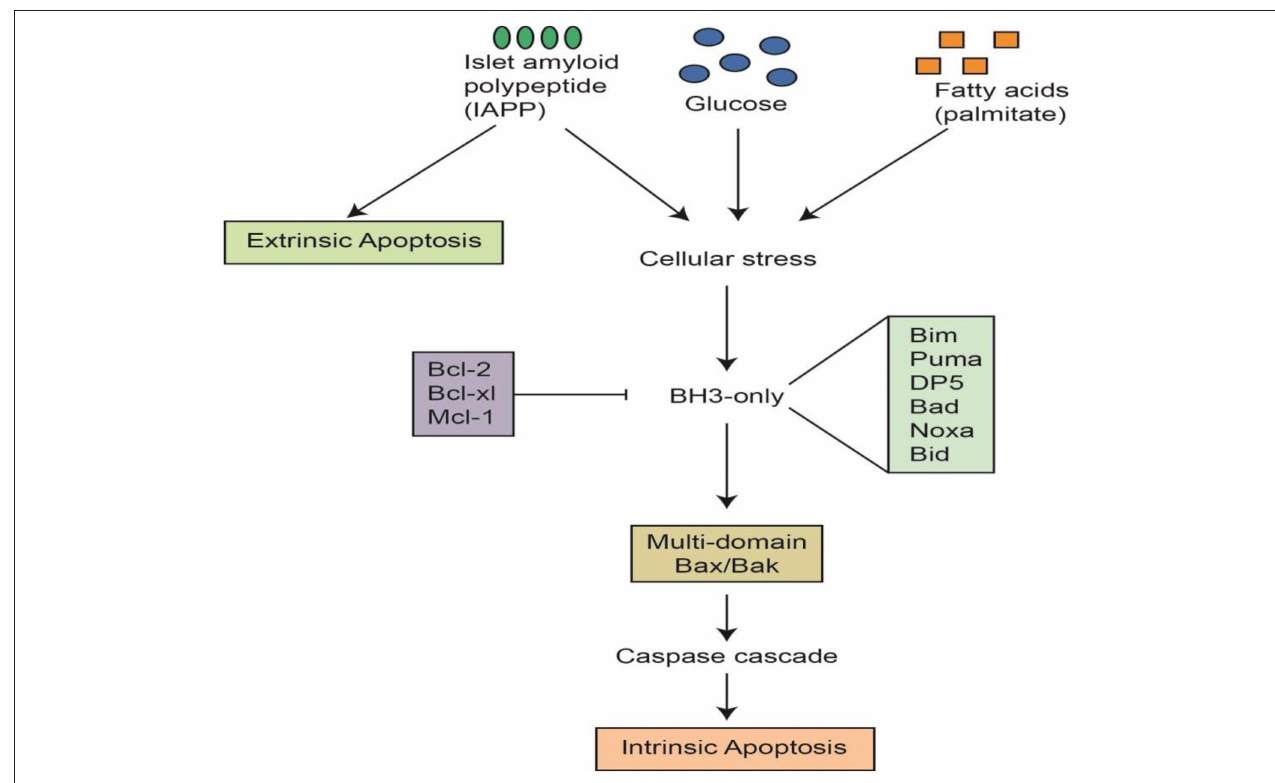
FIGURE 3 | Apoptotic signals and cascades in pancreatic β cells. This figure was graciously provided by Helen Thompson and Jibran Wali, Islet Biology Laboratory, St Vincent’s Institute,